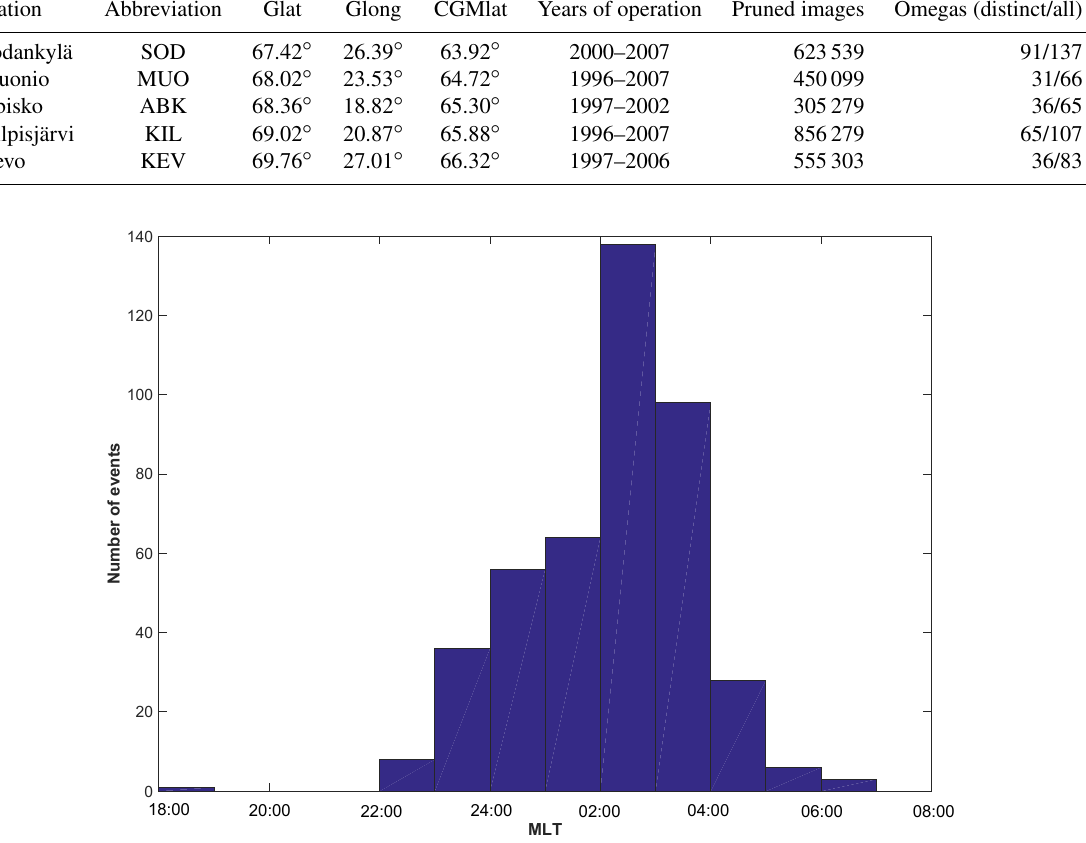
Figure 2. The magnetic local time distribution of omega-like structures has a peak value at